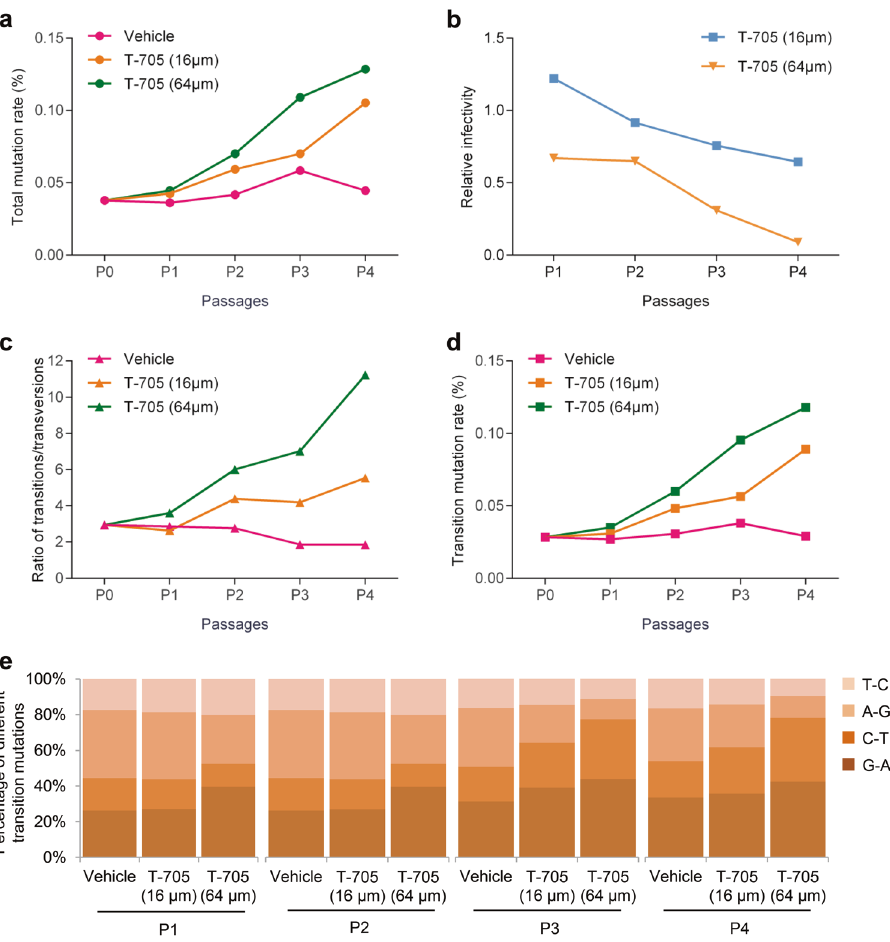
Fig. 1 Infectivity and mutation analysis of SFTSV in four passages of cell culture supernatant from cells treated with different concentrations of T-705. SFTSV strain HNXY2017-66 was serial passaged in T-705 or vehicle-treated Vero cells for four passages (P1 – P4). The cell culture supernatant was collected for the NGS and mutation analysis of the SFTSV genome. Total mutation rates ( a ), ratios of transitions/transversions ( c ), transition mutation rates ( d ), and percentages of different transition mutations ( e ) were calculated. Viral titer and viral genome copy number in the supernatant were also measured, and relative viral infectivity (viral titer/viral genome copy number) is shown ( b